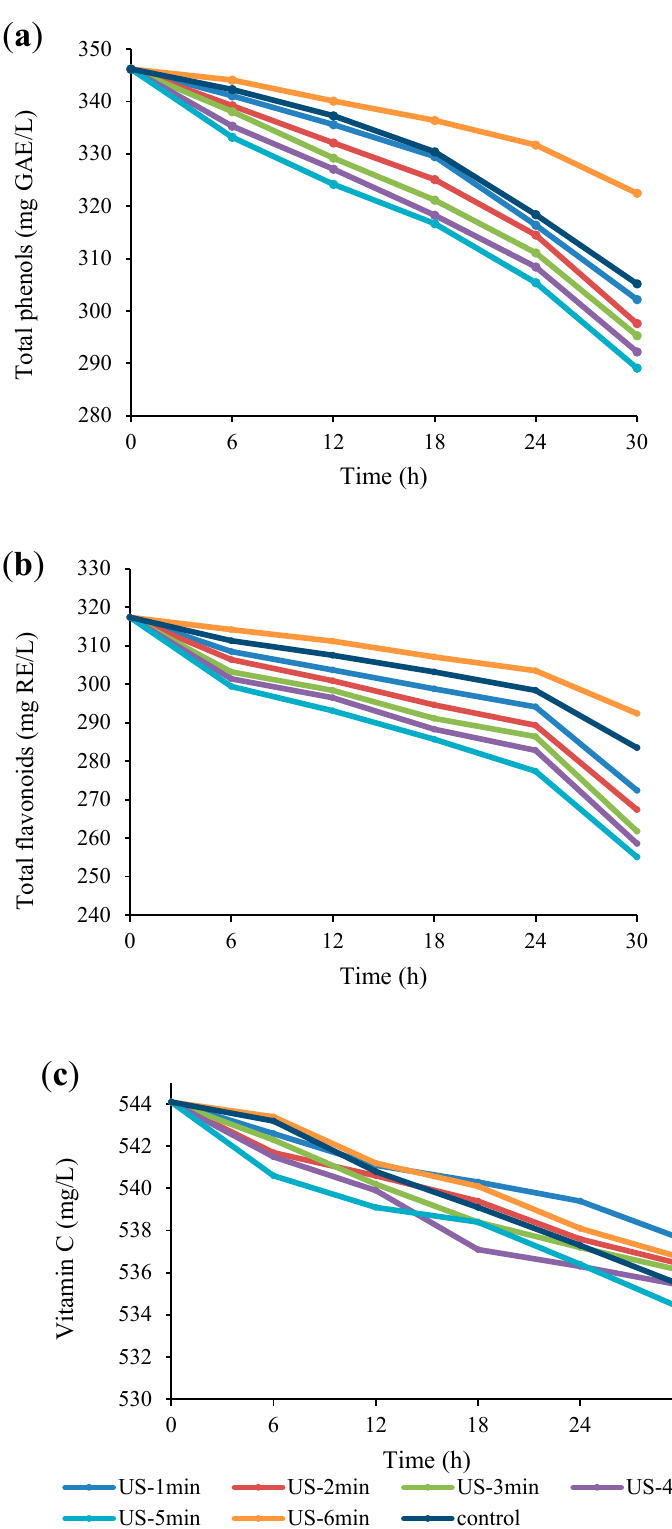
Figure 4. Changes in total phenols ( a ), total flavonoids ( b ), and vitamin C ( c ) content in US-treated and non-US treated Bakraei juice during fermentation. Error bars reveal the standard deviation of each measurement in Bakraei juice during 30 h of fermentation. US-1 min: ultrasound treatment for 1 min, Control: non-ultrasound treated juice.